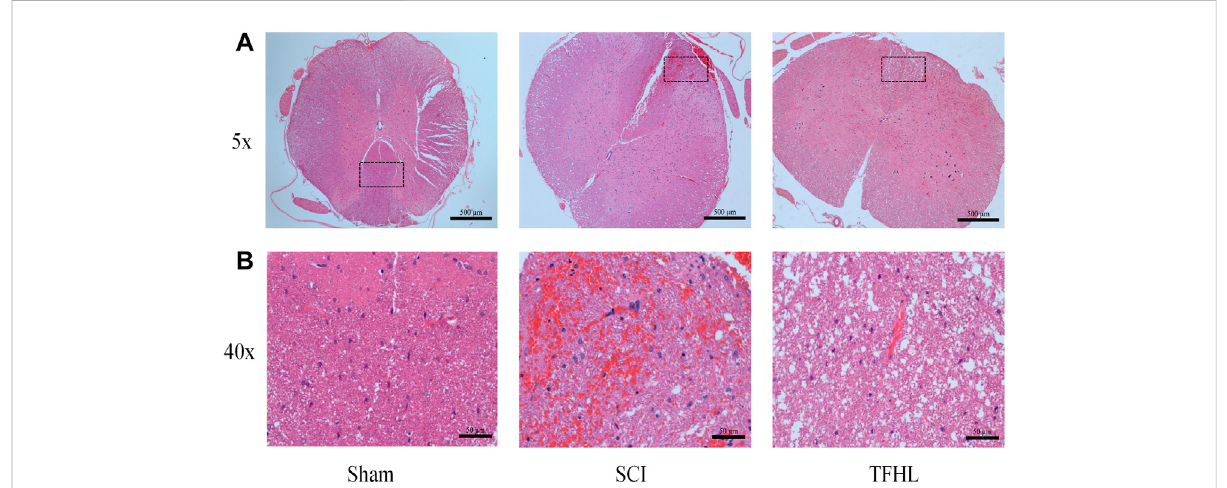
FIGURE 2 TFHL alleviates spinal cord tissue damage after SCI. Assessment of injury in spinal cord sections of each group by HE staining ( n = 3 in each group, cross-section of the T10 segment of the spinal cord). (A) Under ×5 magni fi cation, theoverall structure of the spinal cord tissue of each group was observed, with scale bars = 500 μ M. (B) Under ×40 magni fi cation, the pathological changes of the injured spinal cord tissue in each group were seen, with scale bars = 50 μ M. The black dashed box is the observation part under the ×40 magni fi cation lens.